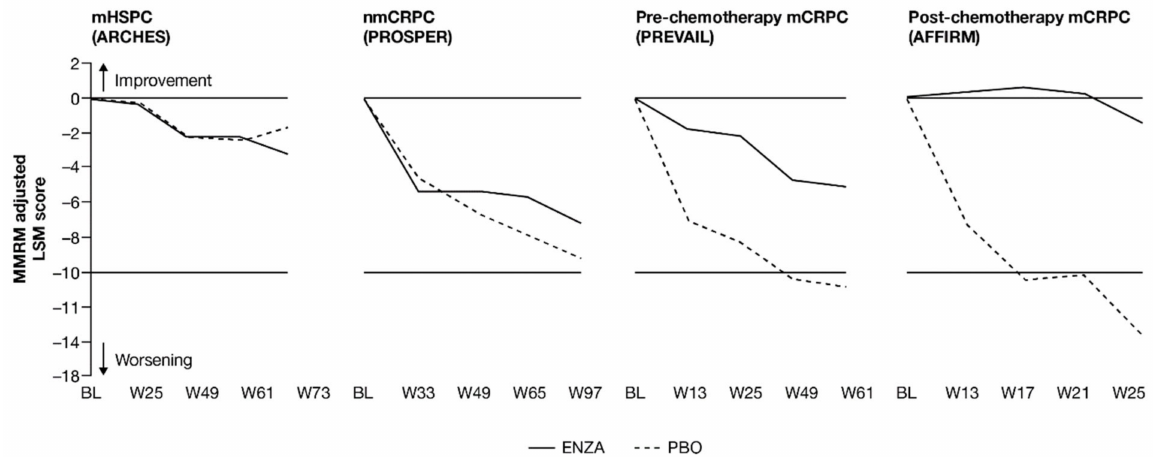
Figure 5. Adjusted change from BL in FACT-P total score. ENZA indicated by solid line, and control group indi- cated by dashed line. Abbreviations: BL: Baseline; ENZA: Enzalutamide; FACT-P: Functional Assessment of Cancer Therapy—Prostate; LSM: Least squares mean; mCRPC: Metastatic castration-resistant prostate cancer; mHSPC: Metastatic hormone-sensitive prostate cancer; MMRM: Mixed-model repeated measure; nmCRPC: Non-metastatic castration-resistant prostate cancer; PBO: Placebo; W: